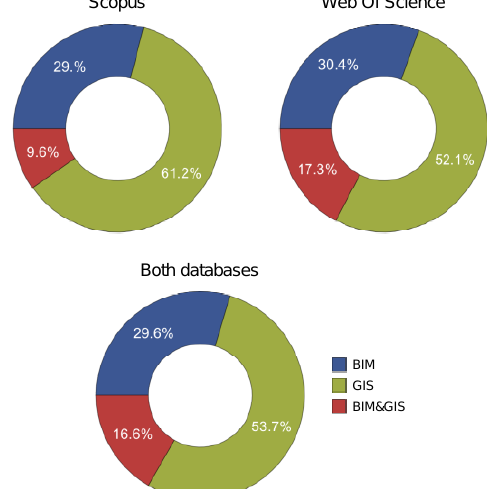
Figure 6. Selected articles concerning different information management approaches in WoS, Scopus and both